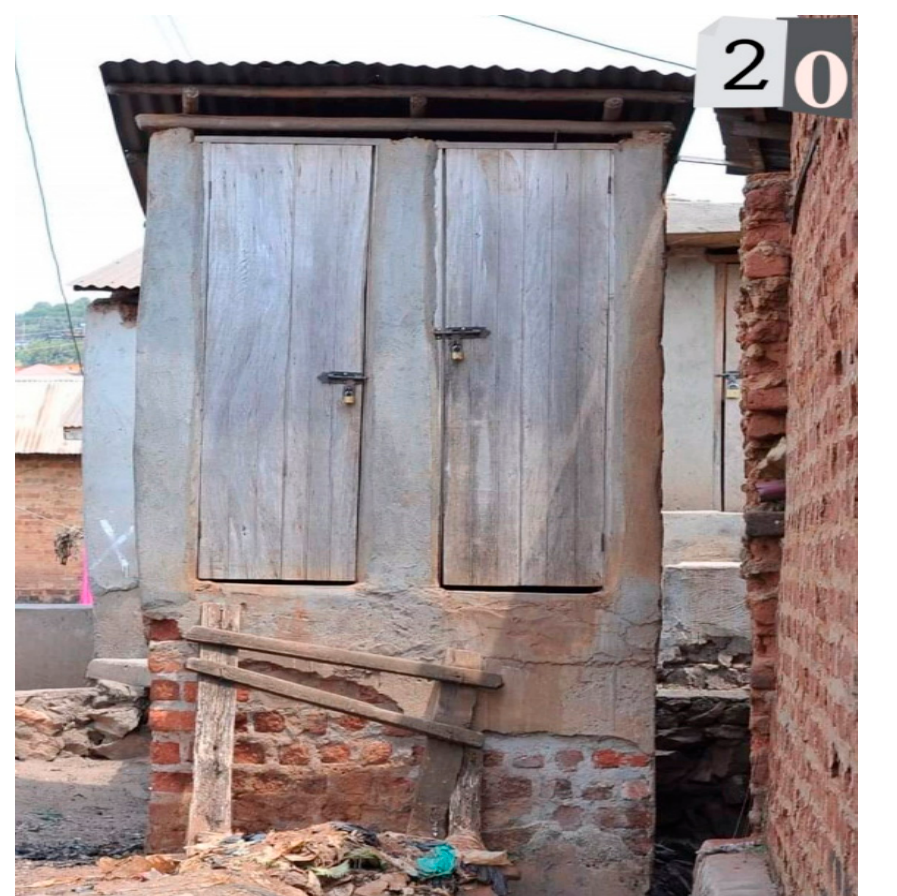
Figure 2. Community Latrine (photo number 20).